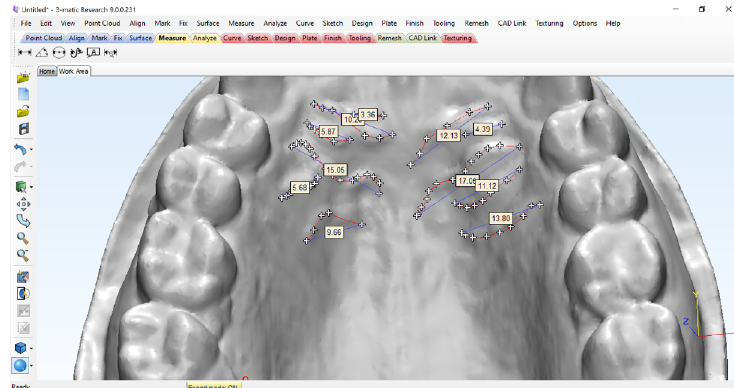
Figure 3. Rugae length measurement on 3-Matic Research